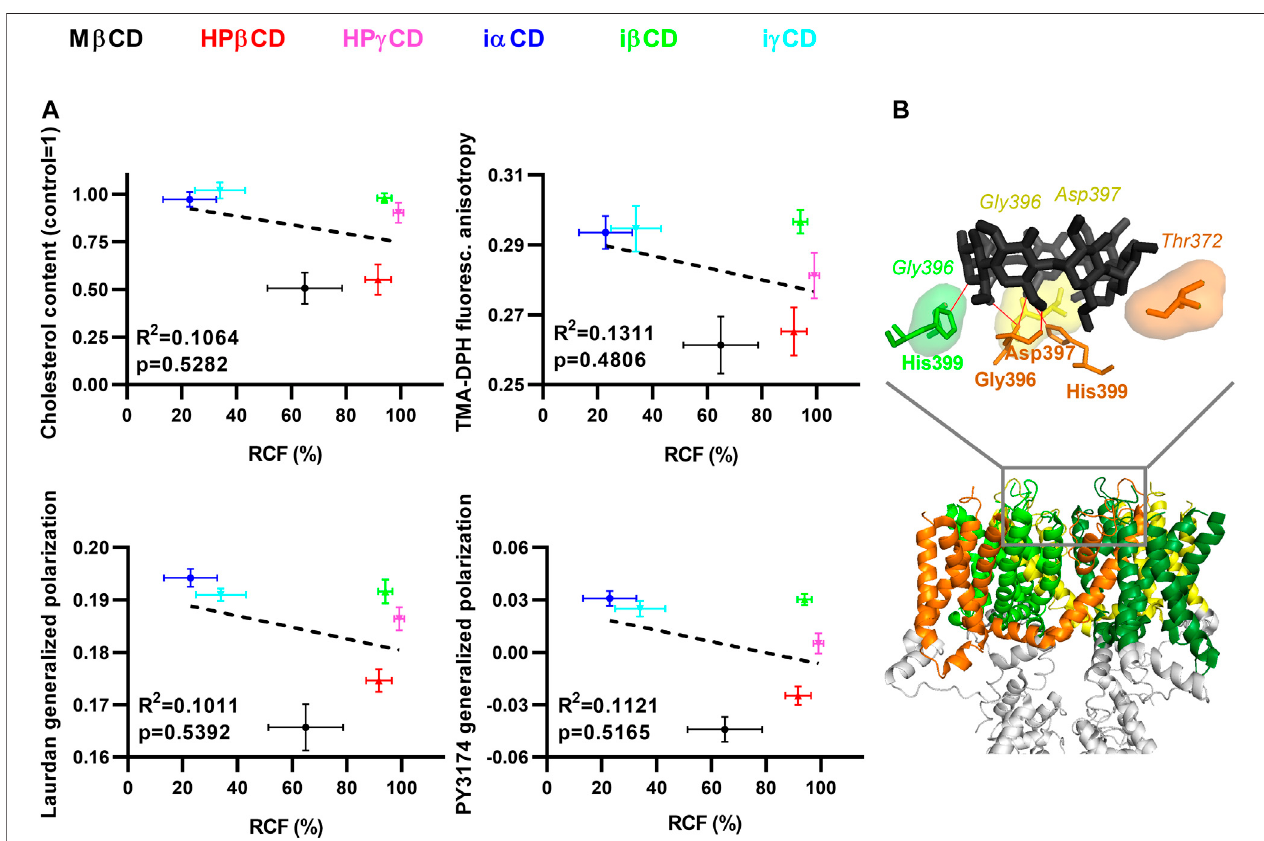
FIGURE 4 | Potential mechanisms of CD actions on K V 1.3. ( A ) To correlate changes between electrophysiological parameters, cholesterol levels and membrane biophysicalparameters,CHOcellsweretreatedwith5 mMM β CD,HP β CD,HP γ CD,i α CD,i β CDori γ CDfor1 h,whichwasfollowedbydeterminationofK V 1.3remaining current fraction (RCF), cholesterol level, TMA-DPH fl uorescence anisotropy, and Laurdan and PY3174 generalized polarization (GP), as described previously in detail. Average values ( ± SEM) of cholesterol level, TMA-DPH fl uorescence anisotropy, Laurdan GP and PY3174 GP were plotted as function of RCF values. R 2 and p values determined with linear regression analysis are shown in the panels, which revealed no signi fi cant correlation between RCF and any of the other examined parameters. ( B ) To examine possible direct interactions between CDs and K V 1.3, in silico molecular docking was performed with AutoDock Vina using M β CD (from structurePDB2QKH(black))andthecryo-electronmicroscopicstructureofKv1.3(PDB7EJ1).S1-S6transmembranehelicesofdifferentsubunitsareshownindifferent colors, while the rest of the channel (tetramerization domain) is displayed in grey. One representative binding mode of M β CD to the extracellular surface of the pore domainisshownintheupperpanel.Aminoacidstakingpartinligand-targetinteractionswereidenti fi edanddisplayedusingLigPlot+andPyMol.Theidenti fi edhydrogen bonds are illustrated with red lines, while hydrophobic interactions are labeled by shaded areas between M β CD and K V 1.3. Amino acid residues taking part in hydrogen bonds are shown in bold, while those involved in hydrophobic interactions are represented in italic.